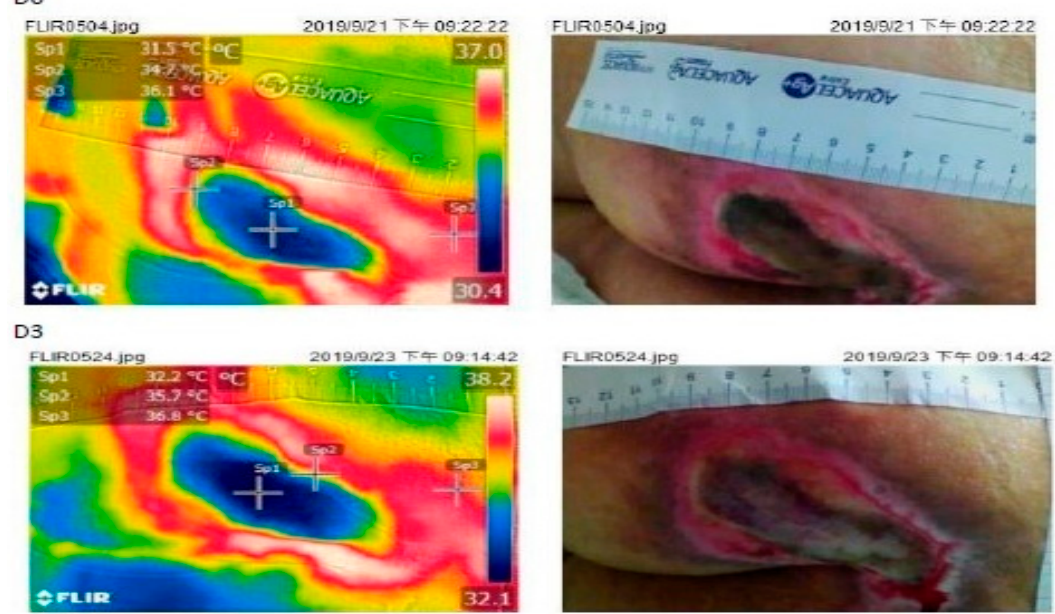
Figure 3. Case of better wound healing (upper: Day 0 and lower: Day 3). IRTc: wound bed (Sp1) IRTp: periwound skin (Sp2); IRTn: normal skin (Sp3).